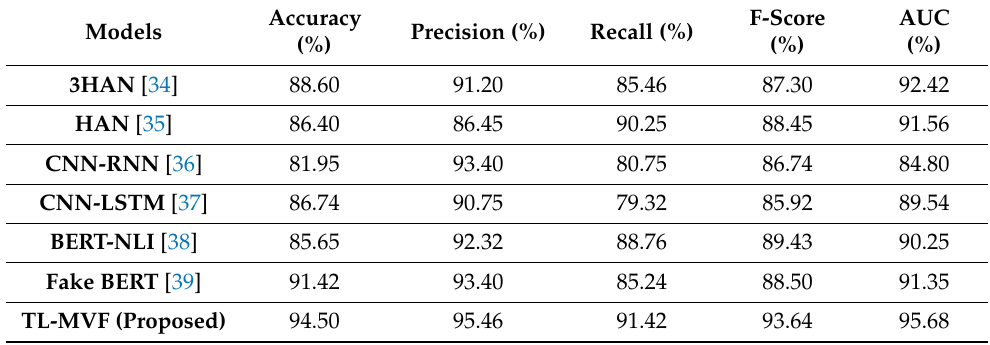
Table 8. Comparative results of the proposed TL-MVF with other models over the Pymedia dataset.